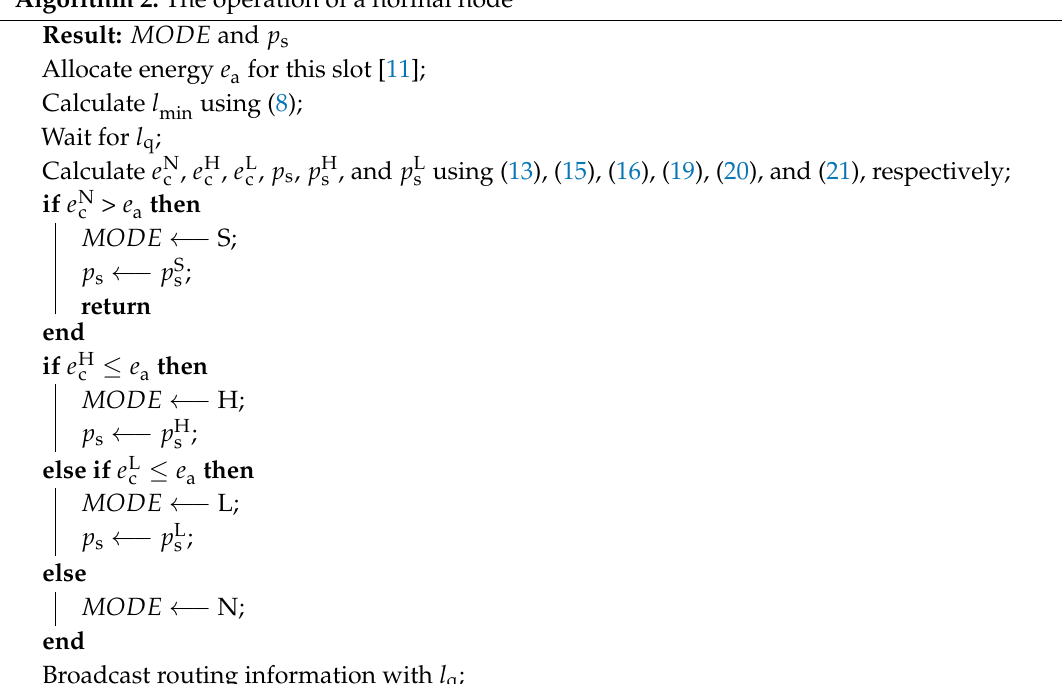
Algorithm 2: The operation of a normal node